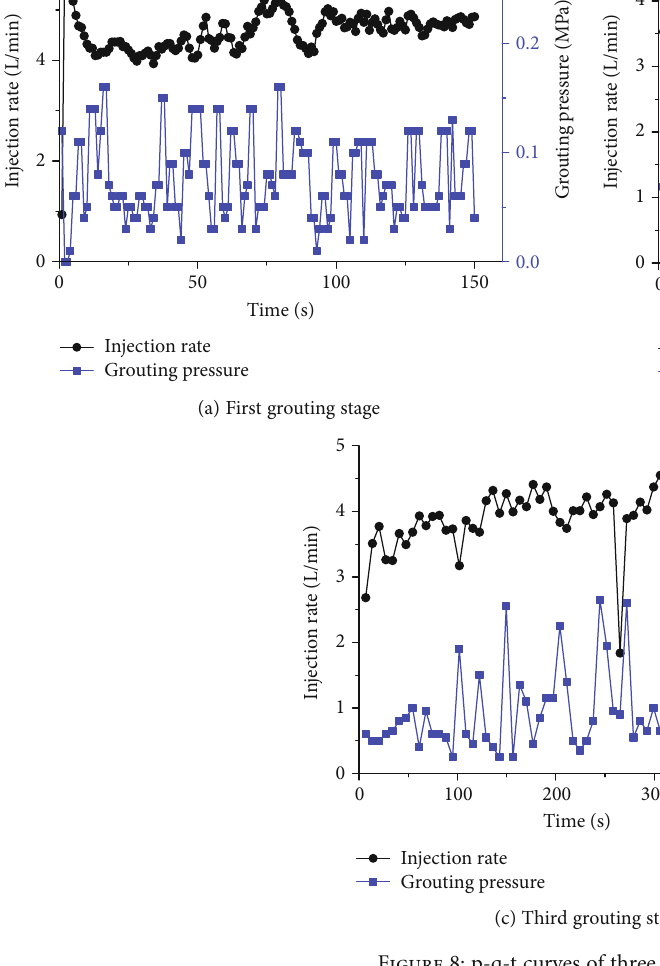
Figure 8: p-q-t curves of three grouting stages.